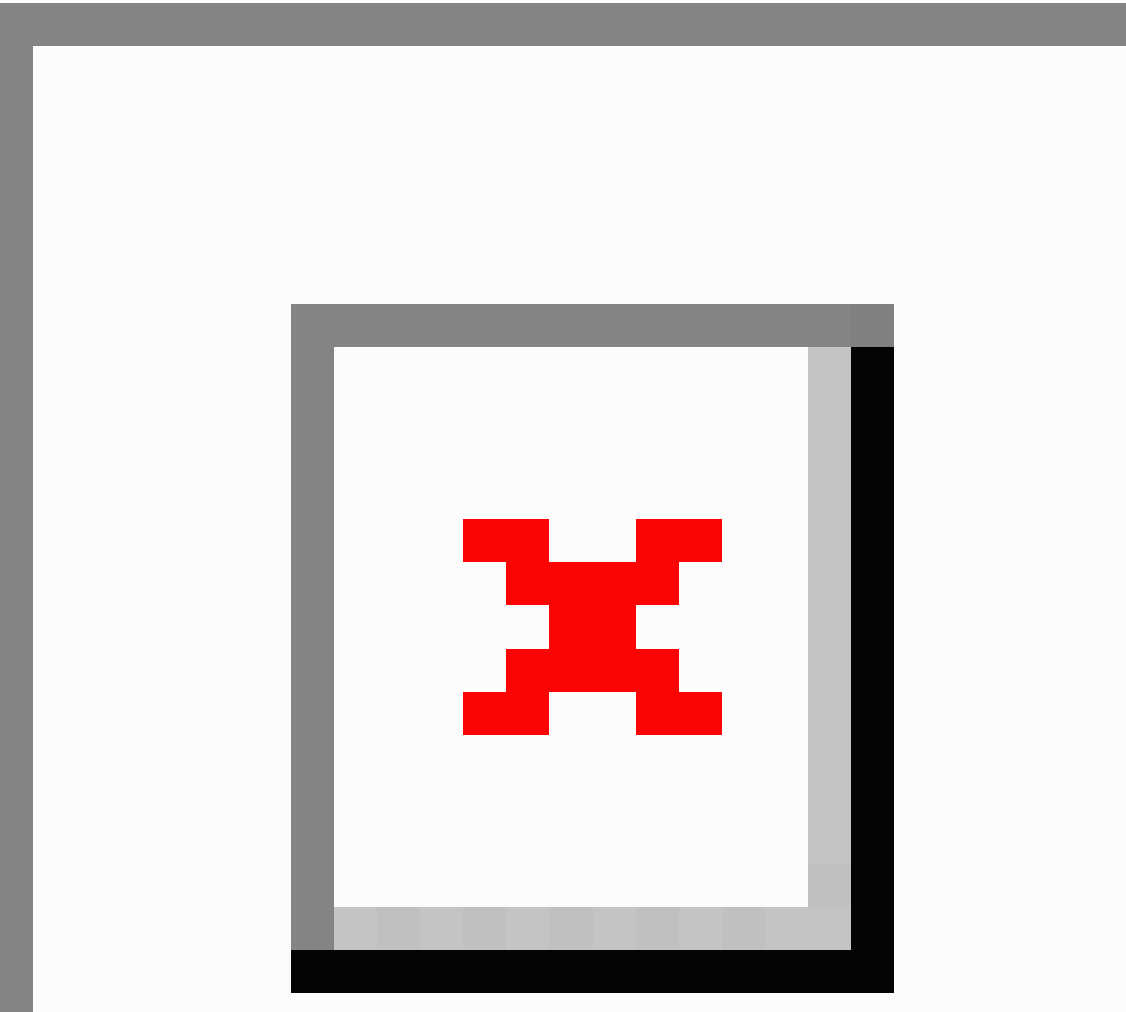
Figure 1. The relationship between hearing thresholds in series 1 and 2 (first two columns on left) and between series 1 and 3 (last two columns on right) calculated in a group of 51 and 37 subjects,